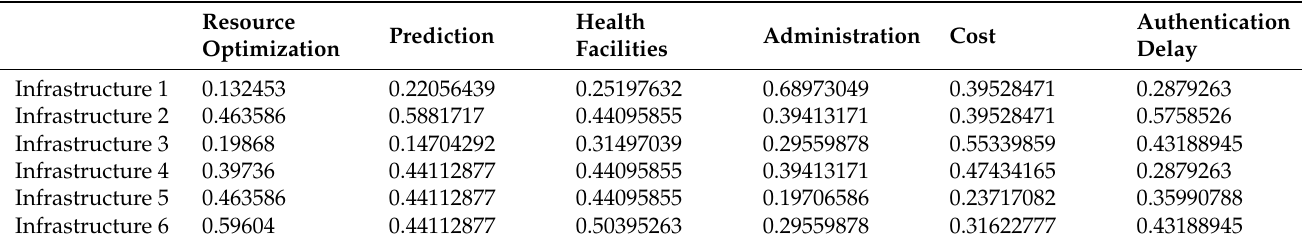
Table 7. Normalized